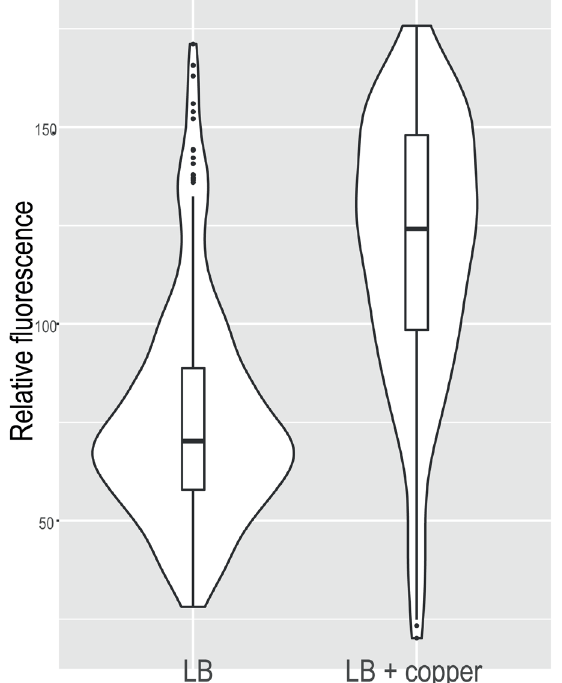
Figure 4. Single-cell fluorescence intensity of E. coli BW25113 (pHJ101) expressing red fluorescent mScarlet protein under the control of the tolC promoter without (left) or with (right) copper exposure. The violin plots show the distribution of the single-cell fluorescence within the cell population. The median is depicted by the bar in the box; the box represents the 25% and 75% quartiles.